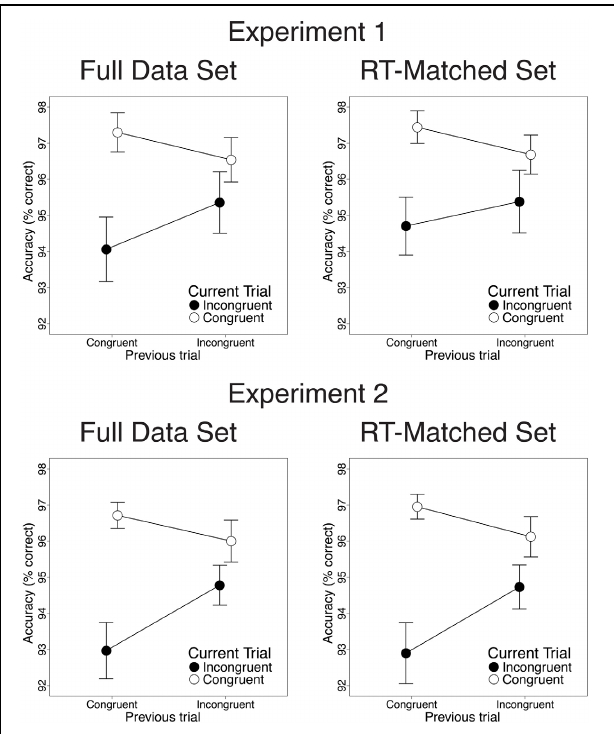
FIGURE 4 | The effects of previous-trial RT tertile on current-trial congruency effects in the RT data. Congruency effects did not differ after the 33% slowest vs. the 33% fastest incongruent trials [Experiment 1: t ( 22 ) = 0 . 20, n.s .; Experiment 2: t ( 25 ) = 1 . 51, n.s .] or congruent